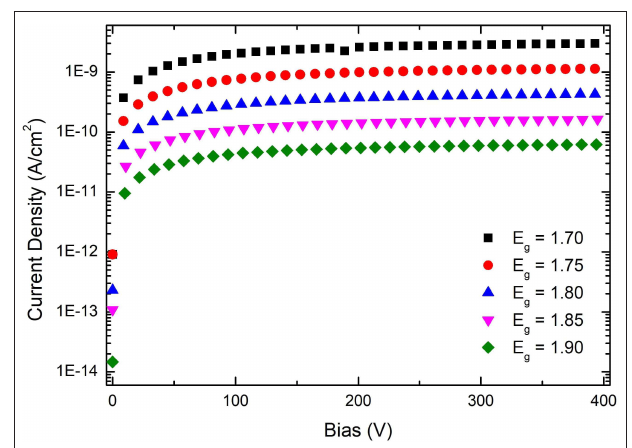
FIGURE 3 | Simulated current density as a function of applied bias for a range of different band-gaps from 1.70